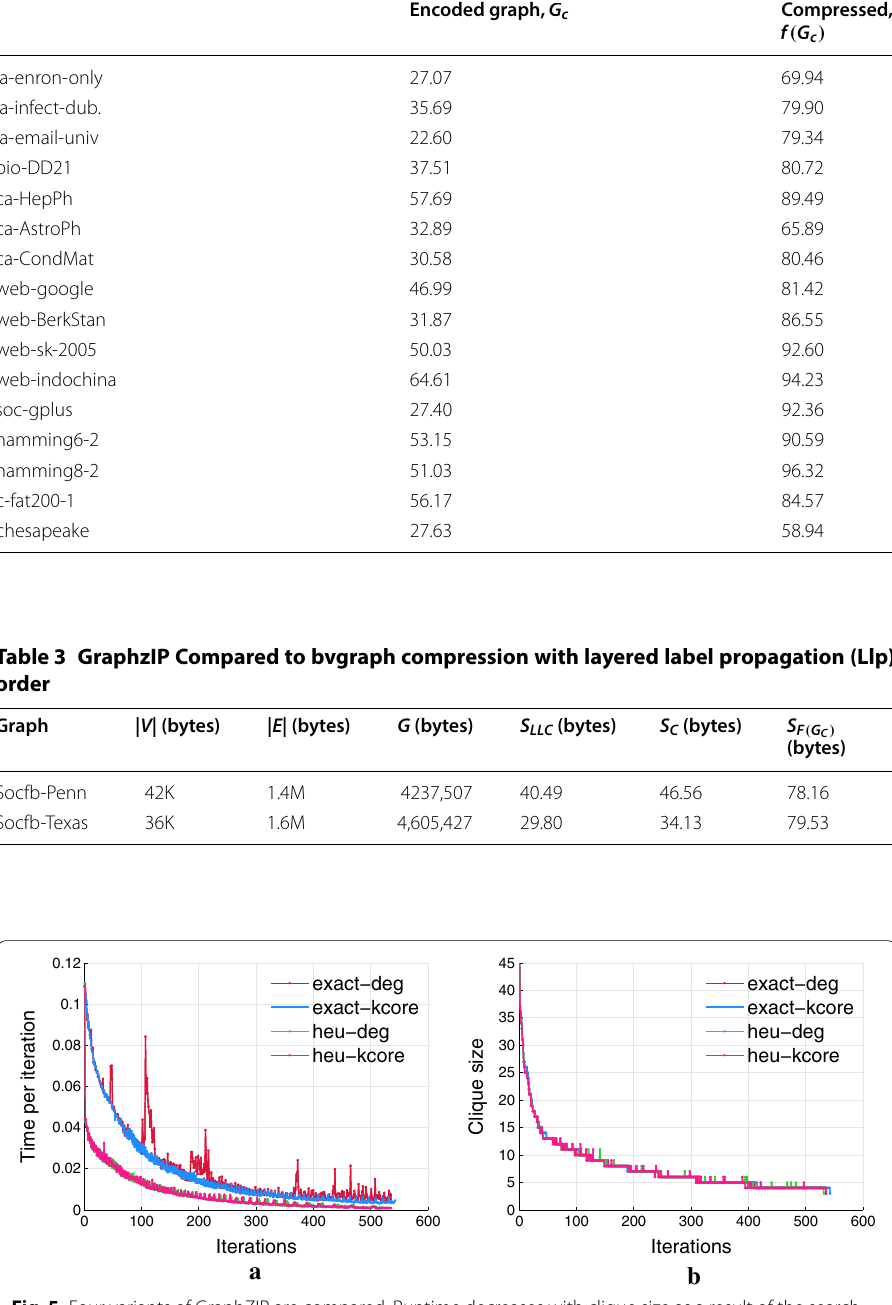
Fig. 5 Four variants of GraphZIP are compared. Runtime decreases with clique size as a result of the search space shrinking after each clique is found and removed from the graph. Further, the heuristic is 2-3 times faster than the exact clique finder. a Time. b Clique size